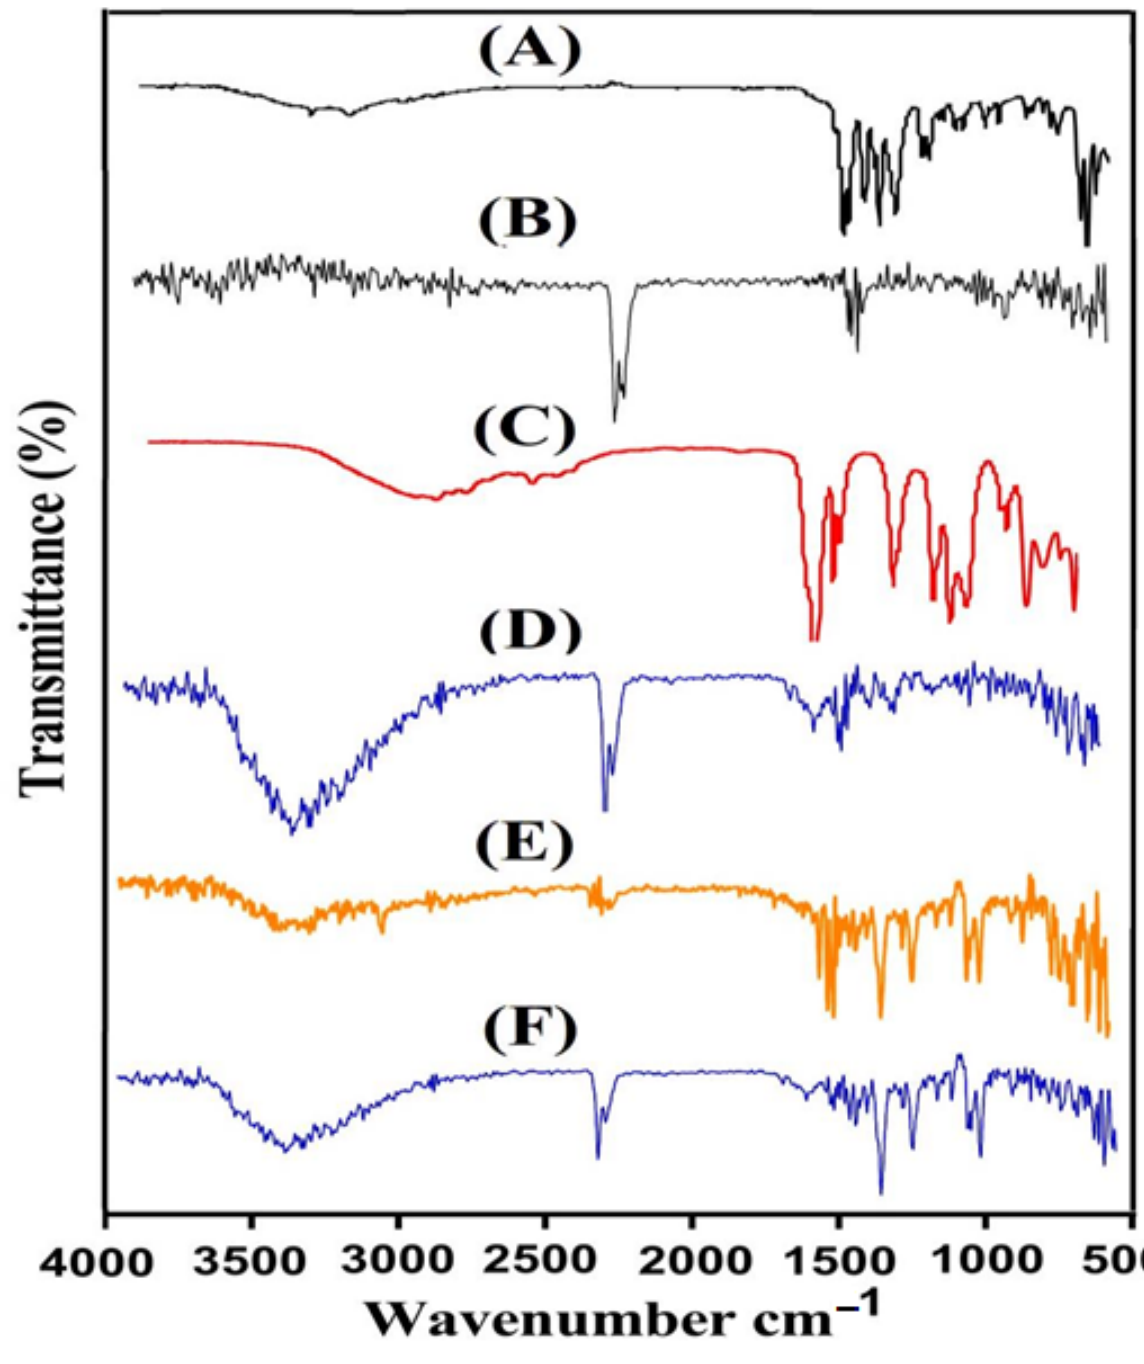
Figure 2. FTIR spectra of (A) CS, (B) Al, (C) Aa, (D) the unloaded CS/Al-g-pAa hydrogel, (E) Kt, and (F) the drug-loaded CS/Al-g-pAa hydrogel.